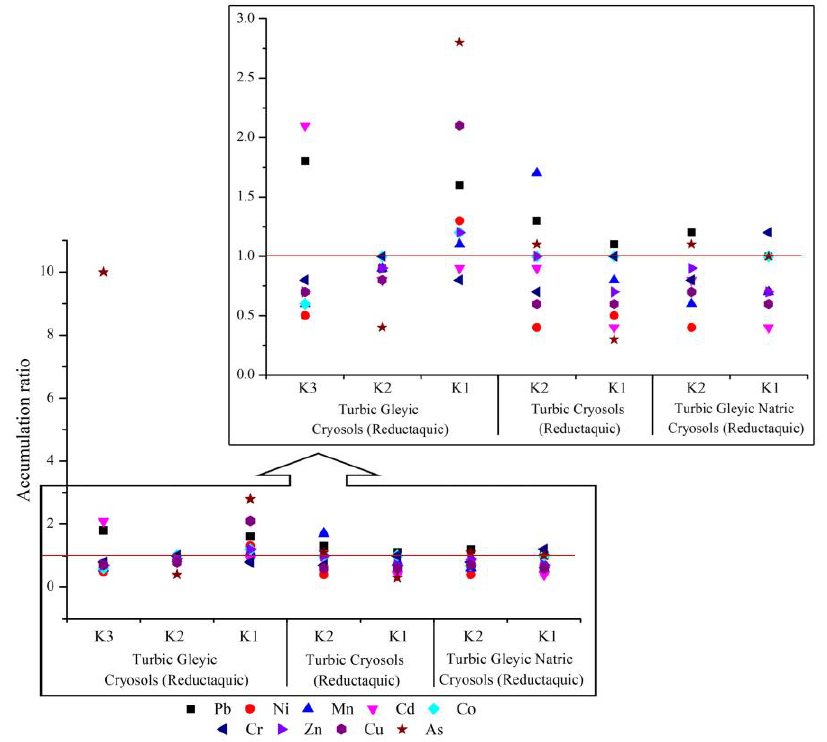
Figure 8. The nature of the accumulation of trace elements in the soil profile of the dominant sub- types of Cryosols of the Khannya – Nakyn interfluve. of Cryosols of the Khannya–Nakyn